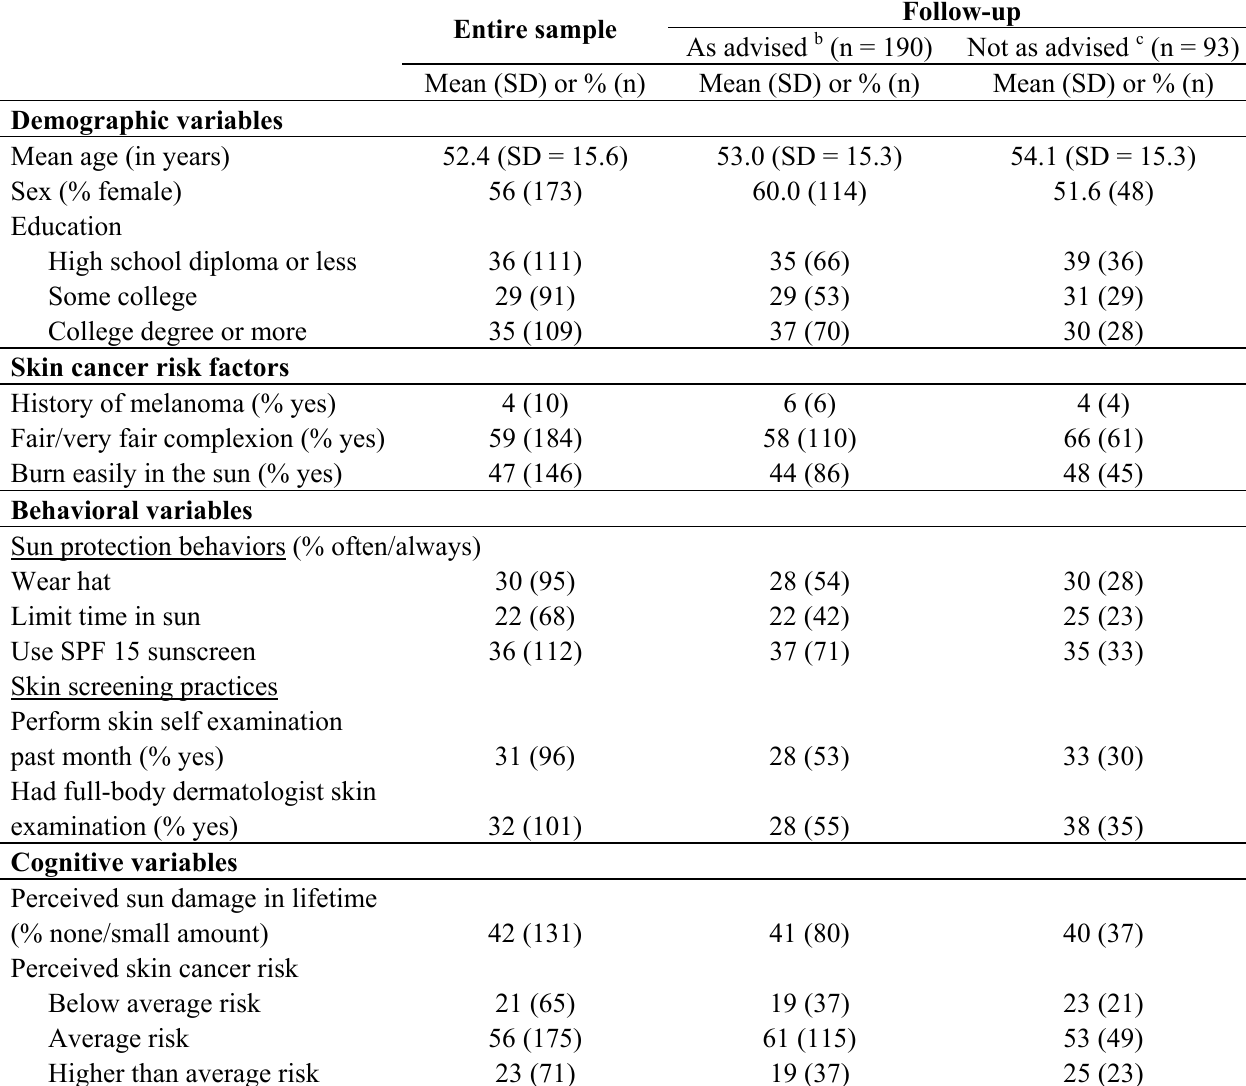
Table 1. Demographics, skin cancer risk factors and baseline behavioral and cognitive variables for individuals participating in a beach-based skin cancer screening in Massachusetts in 2007 (n = 312) and by whether follow-up was as advised (n = 283).